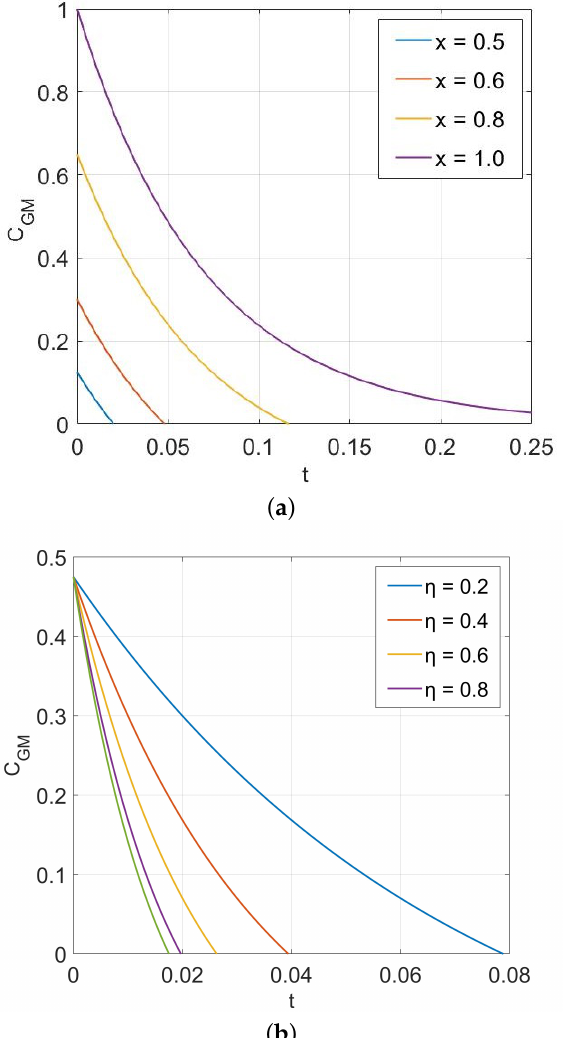
Figure 1. Genuine multipartite concurrence plotted against time (in seconds) for the spectral density J ( ω ) = η / [ 2 π c 2 ( ω )] at zero temperature (for n = 8). ( a ) For various mixing parameters and a fixed interaction coefficient η = 0.2, ( b ) for various interaction coefficients η and a fixed mixing parameter x = 0.7. Entanglement sudden death is observed for states with x < 1, and it occurs more rapidly with increasing η